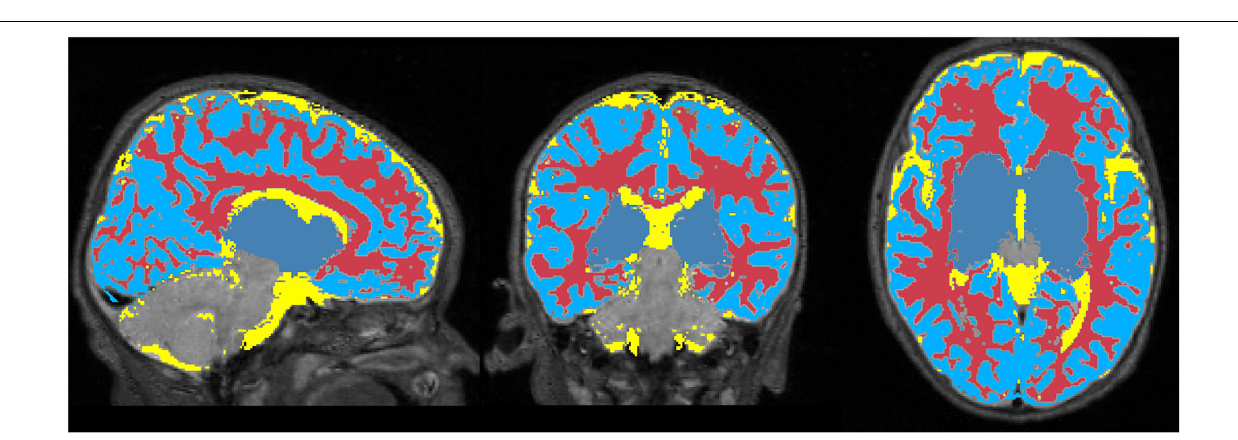
Frontiers in Neuroinformatics |